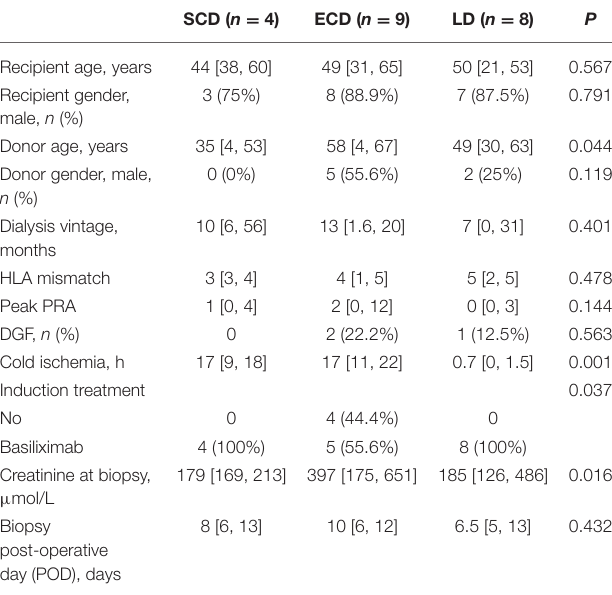
TABLE 1 | Demographics of patient groups analyzed by